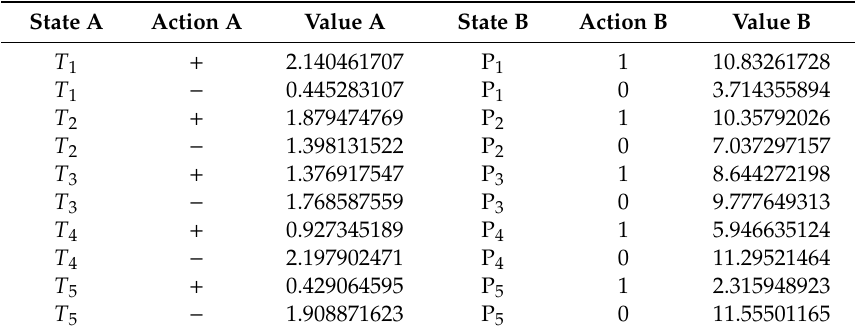
Figure 15. Estimated optimal values of QoS and energy saving per 𝛾 (Discount Factor).